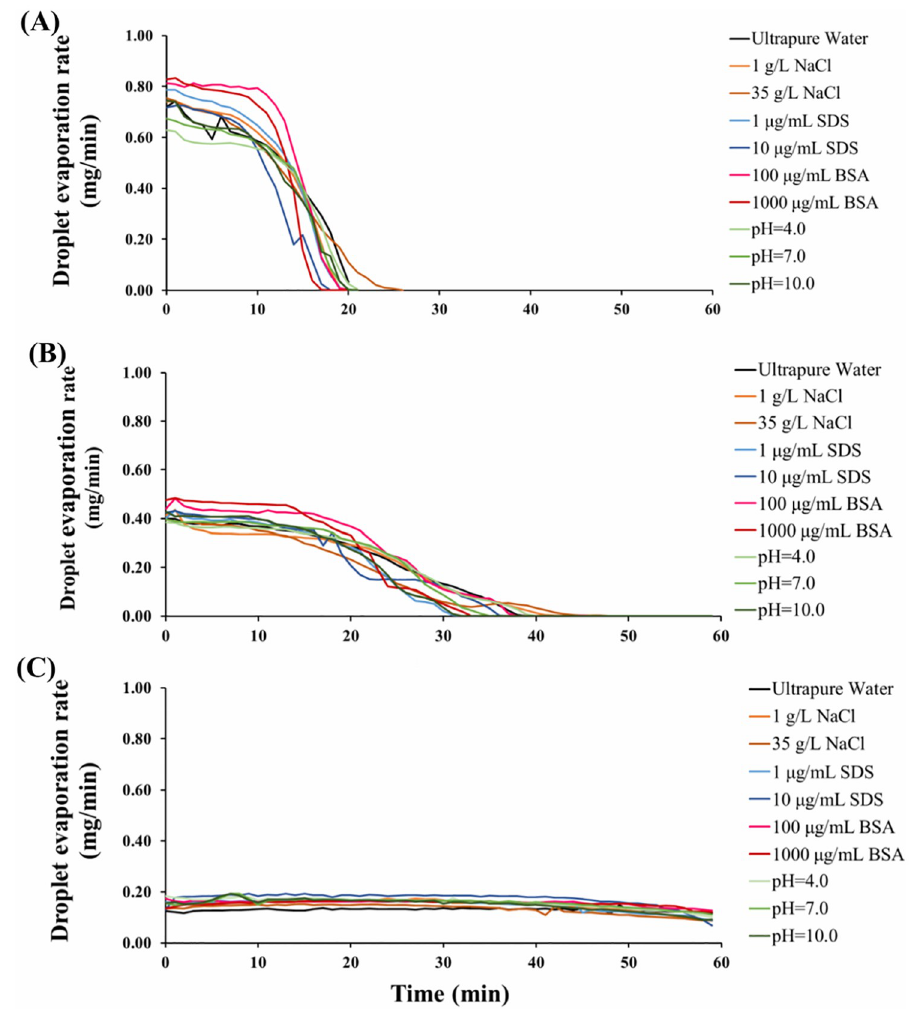
Fig 6. Evaporation rate of droplets with different chemical compositions at (A) 20% RH, (B) 50% RH, and (C) 80% RH. The lines represent the mean of duplicates. Error bars are not shown to facilitate visualization. The relative standard deviation averaged 7%, 18%, and 7% at 20%, 50%, and 80% RH,